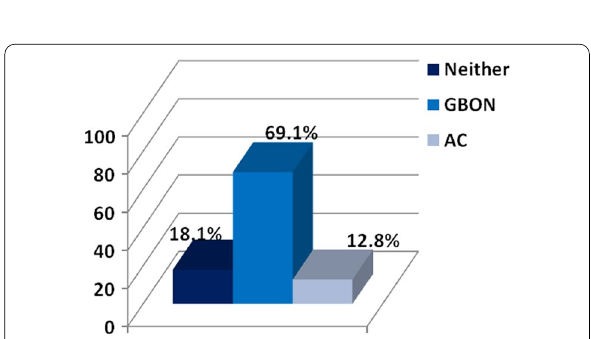
Table 4 Intra-rater agreement on treatment need using the GBON index and the AC index at different treatment need